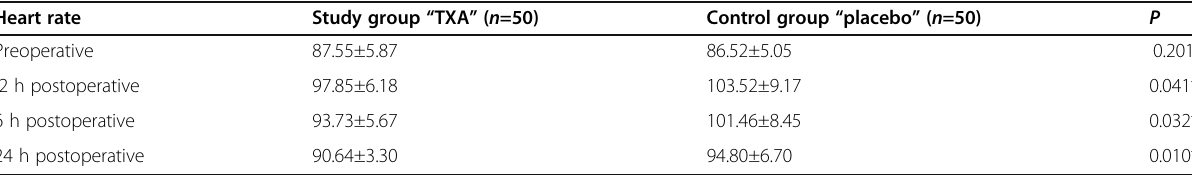
Table 5 Heart rate in both groups through the procedure